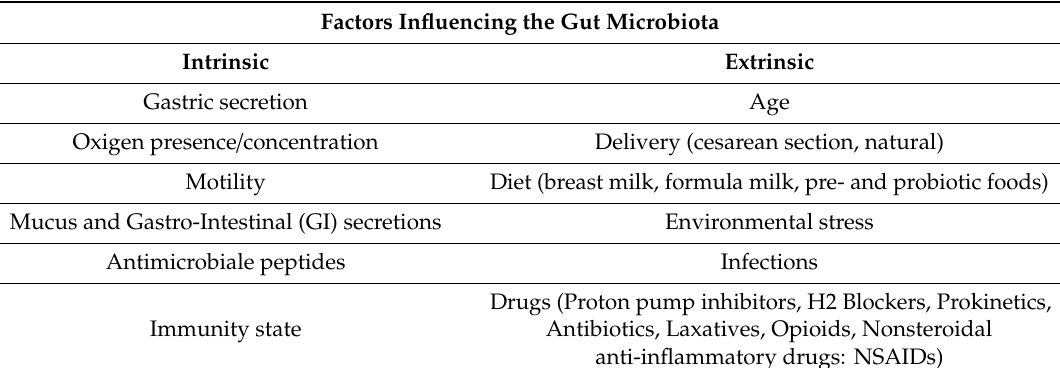
Table 2. The main factors that modified microbiome